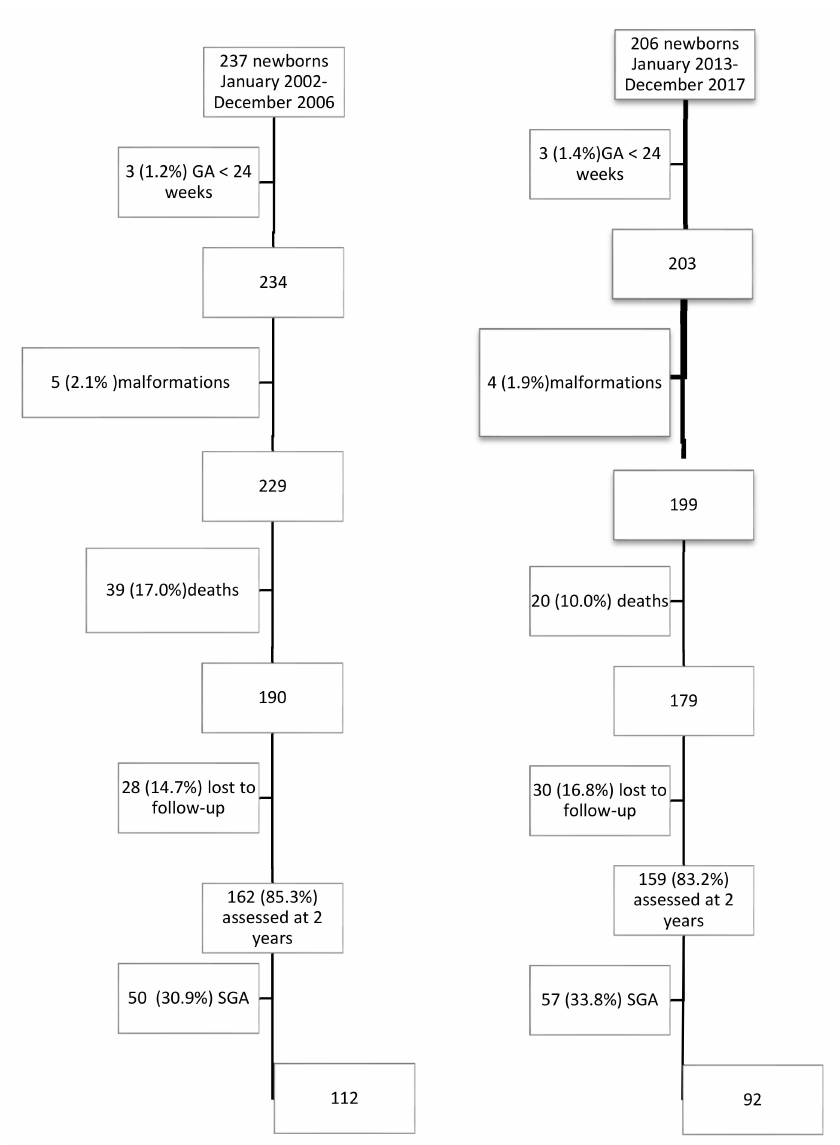
Figure 1. Flowchart of the sample according to inclusion criteria and study population. GA: gesta- tional age. SGA: small for gestational